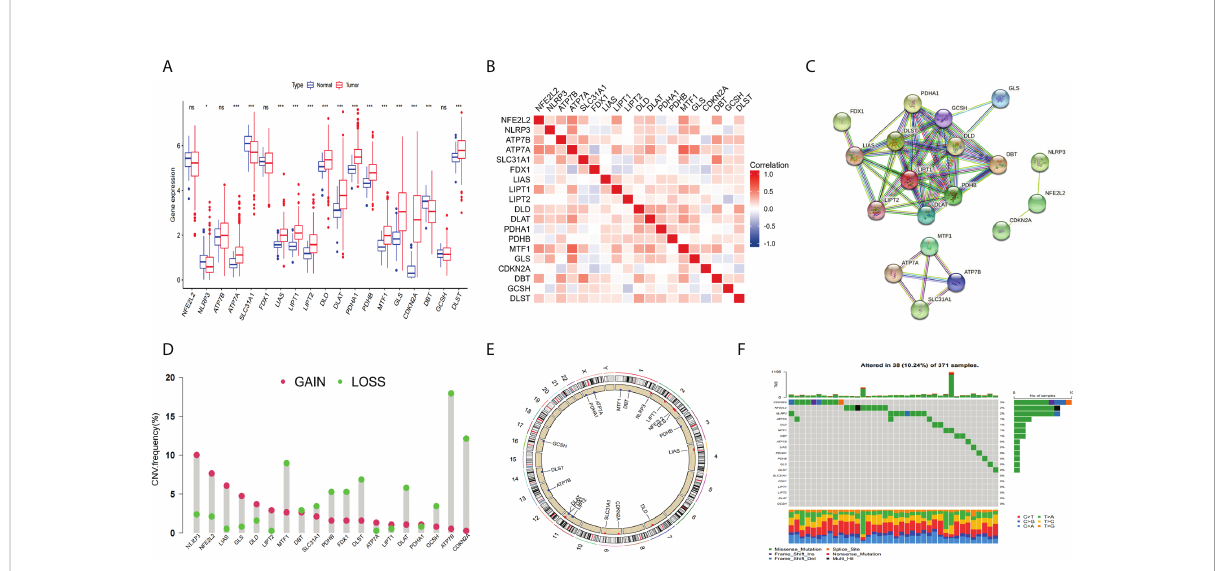
FIGURE 2 Expression and genetic alteration of CRGs in HCC. (A) the expression of 19 CRGs in HCC and normal tissues. (B) correlations between the expression of CRGs; (C) Protein-protein interaction (PPI) networks between CRGs; (D – F) the CNV and mutation frequency and classi fi cation of